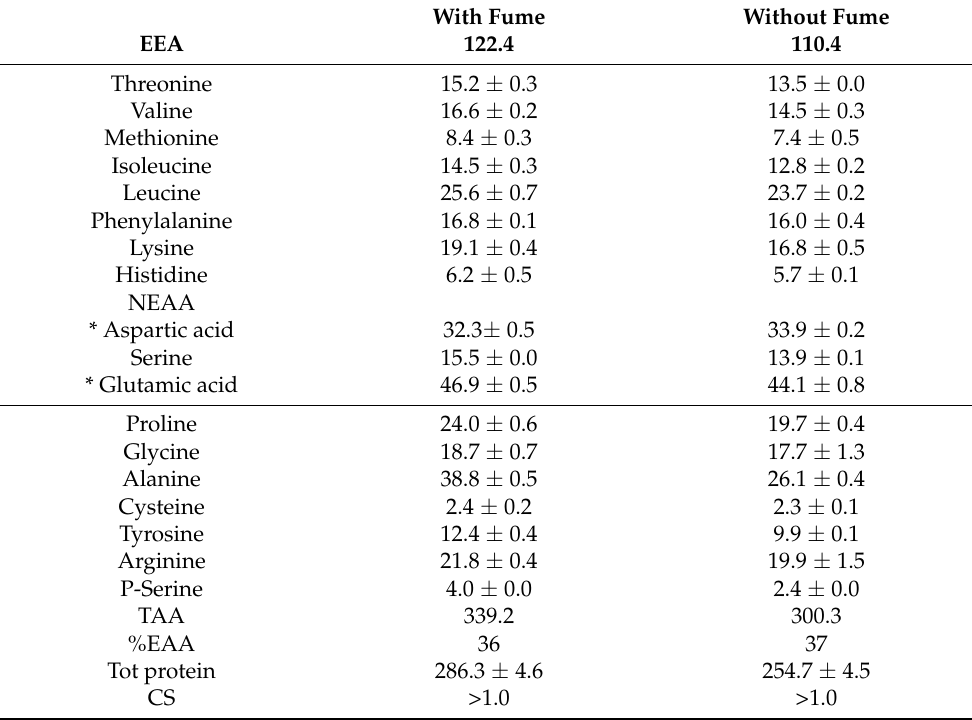
Table 9. Amino acids, essential Amino acids (EAA), nonessential Amino Acids (NEAA), total amino acids (TAA) and total protein (mg g − 1 DW, n = 2) of biomass cultivated with and without fume. %EAA = essential amino acids as % of total and CS = chemical